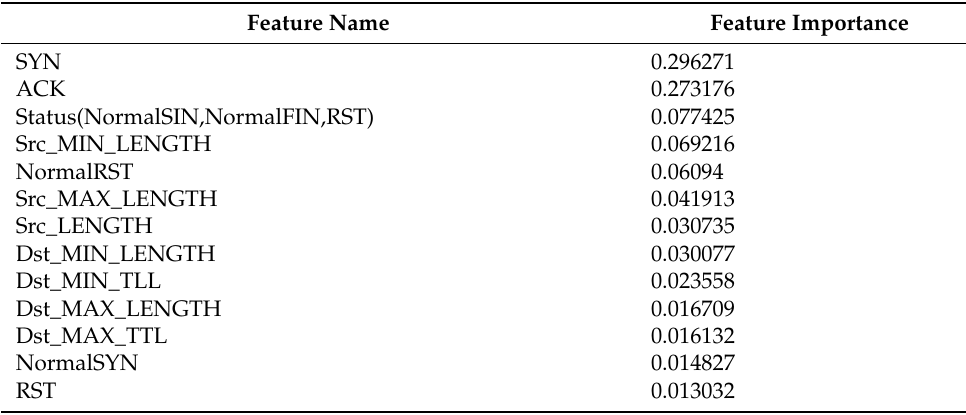
Figure 4. Distribution of the attacks and benign sessions in the dataset. Table 5. Analysis of the correlation between